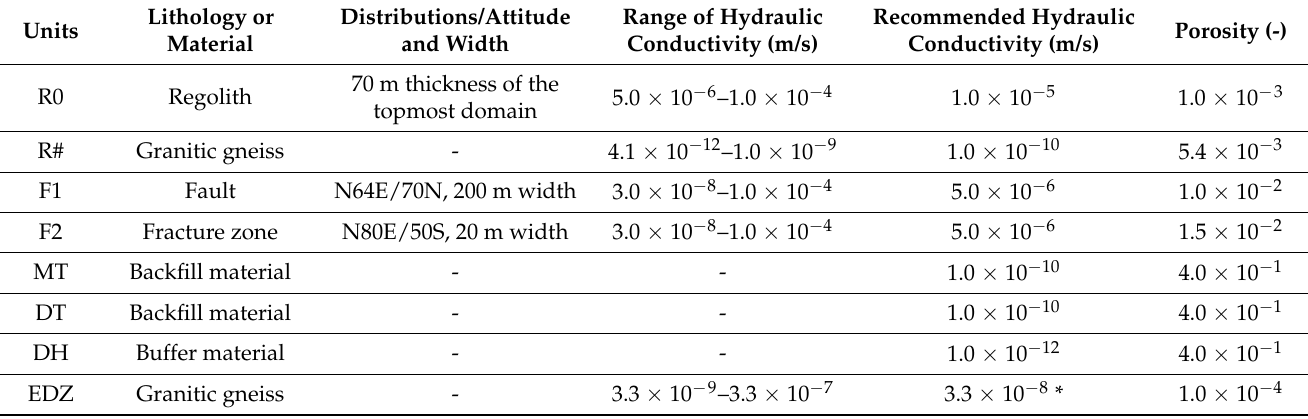
Table 1. The flow properties of hydrogeological units and EDZ for the conceptual model in this